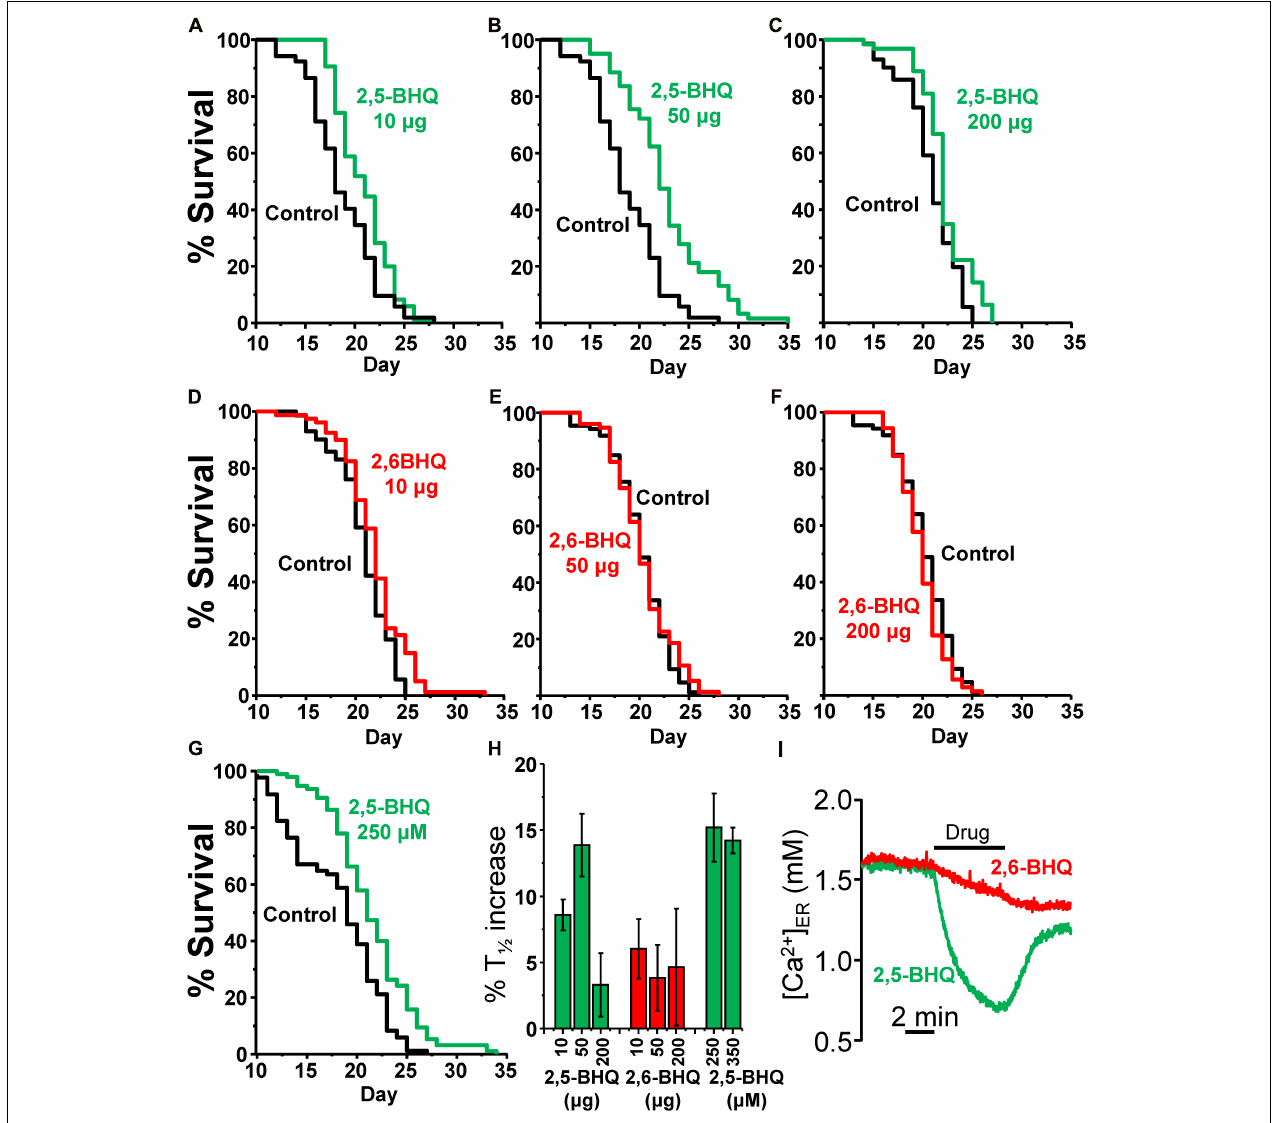
FIGURE 1 | Effects of 2,5-BHQ and 2,6-BHQ on survival in C. elegans . Panels A–F show representative survival plots corresponding to parallel lifespan assays performed using γ -cyclodextrin-inclusion compounds in the following conditions: Control/2,5-BHQ ( A :10 µ g; B :50 µ g; C :200 µ g) and Control/2,6-BHQ ( D :10 µ g; E :50 µ g; F :200 µ g), respectively. (G) shows a representative survival plot from a Control/2,5-BHQ lifespan assay in which 250 µ M 2,5-BHQ was dissolved in the NGM agar. The assays shown correspond to those marked in bold in Table 1 . (H) shows the mean increase in survival obtained in a series of lifespan assays of